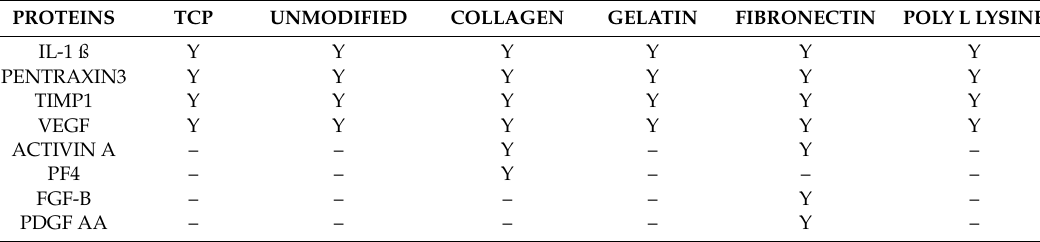
Figure 11. Proteome profile expression of the proteins expressed by cells grown on conventional TCP and unmodified and protein modified PLLA sca ff olds. Prominent expression of 8 proteins, crucial for cardiac fibroblast growth and di ff erentiation was observed in various samples analyzed. Of these 4 proteins, IL-1 ß, Pentraxin3, TIMP1 and VEGF were commonly expressed in all the groups. ( a ) Tissue culture plate (TCP), ( b ) PLLA unmodified, ( c ) PLLA collagen, ( d ) PLLA gelatin ( e ) PLLA fibronectin ( f ) PLLA poly L lysine. Table 1. Expressed proteins with major role in cardiac fibroblast growth and differentiation.